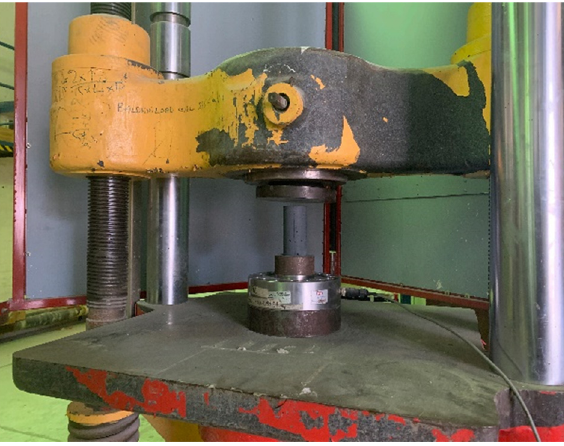
Figure 4: Baldwin machine.